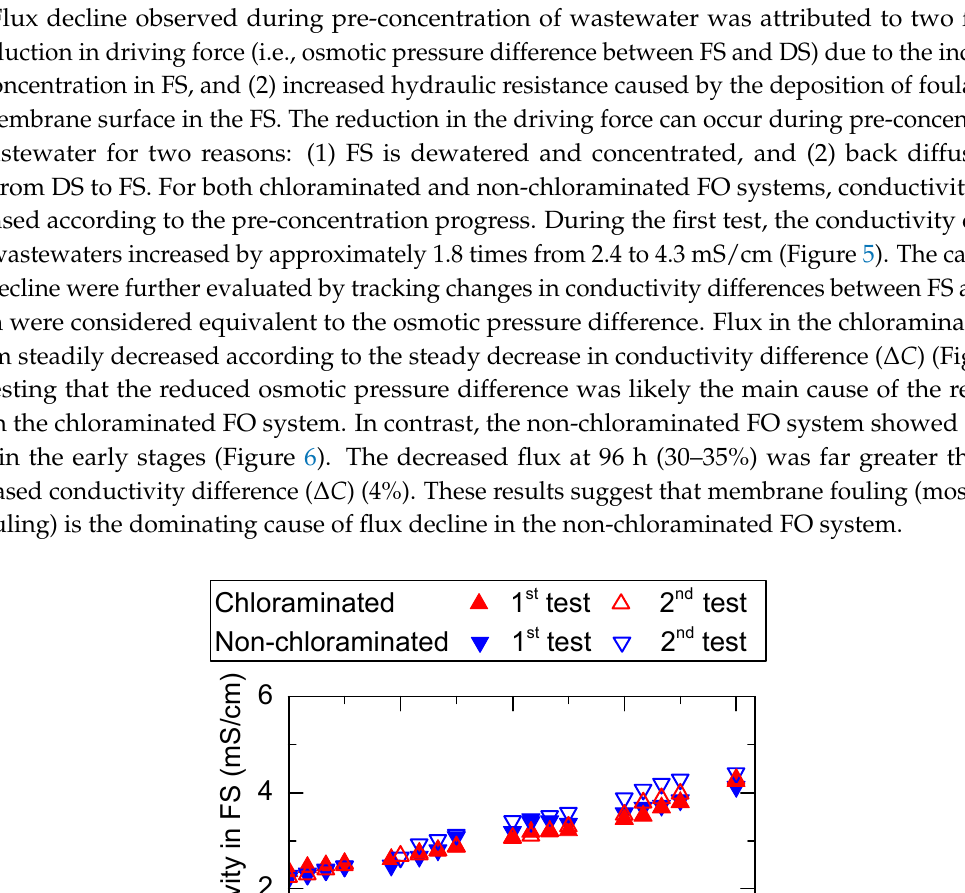
Figure 4. Concentration factor during the pre-concentration of primary wastewater effluent using a FO membrane.